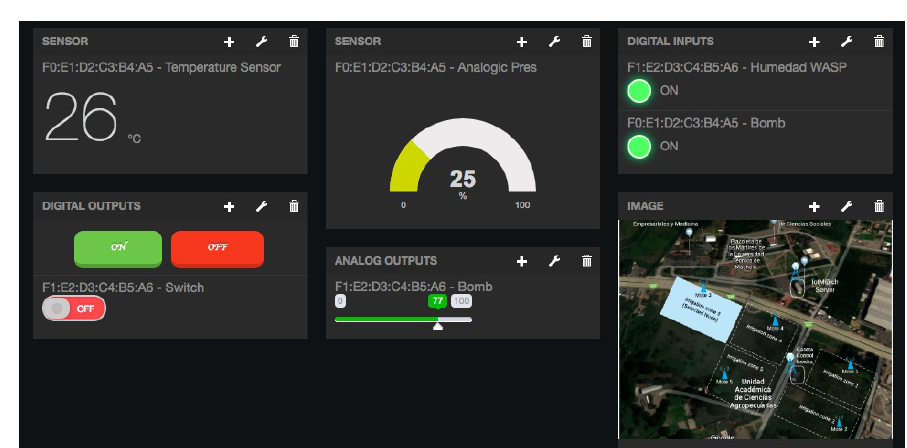
Figure 22. Dashboard list.